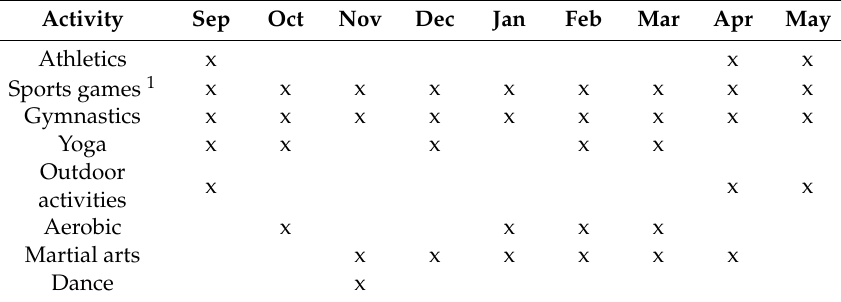
Table 1. Activity plan for the intervention